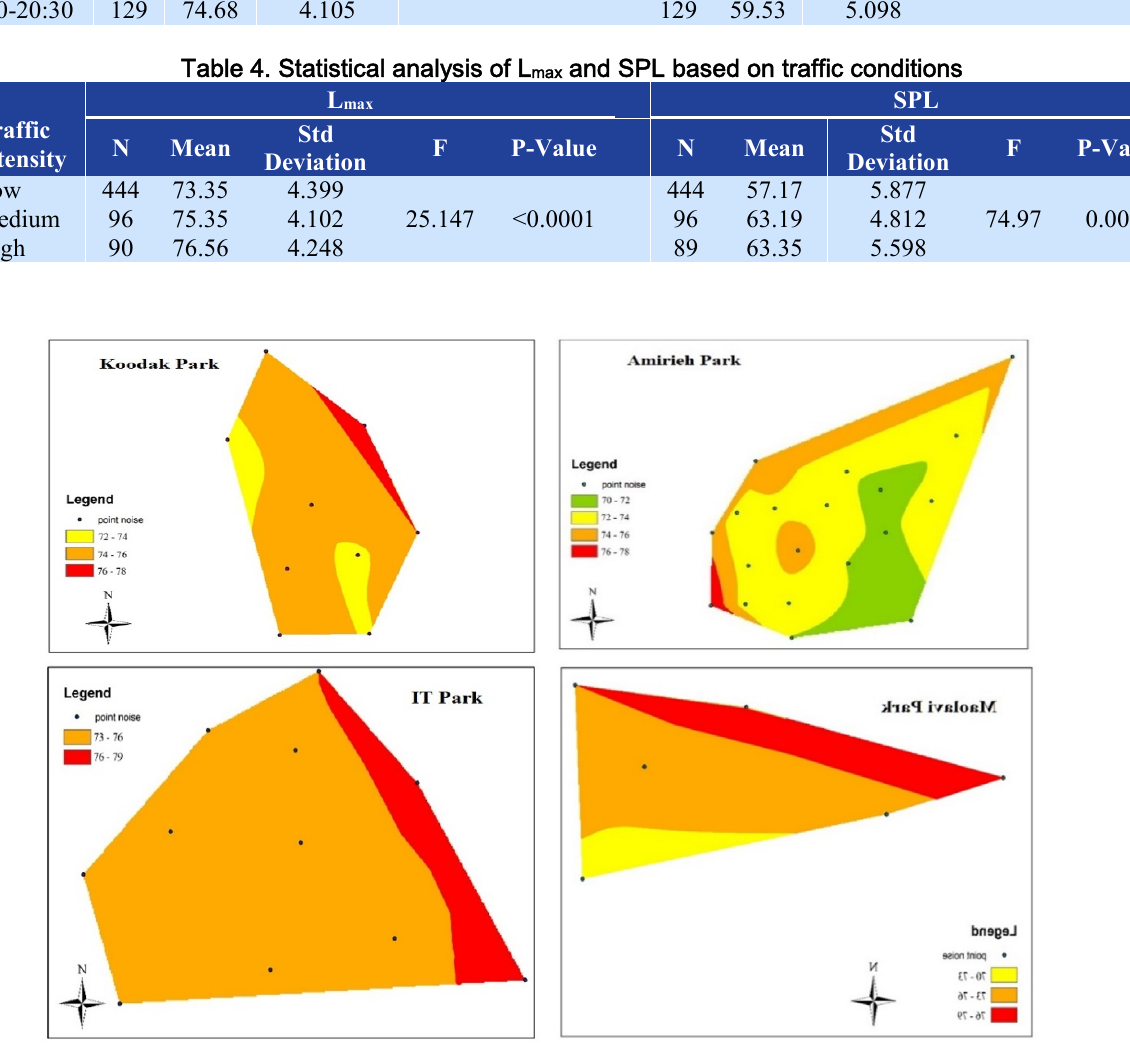
Figure 1. Sound map of the Sanandaj Parks based on Sound Pressure